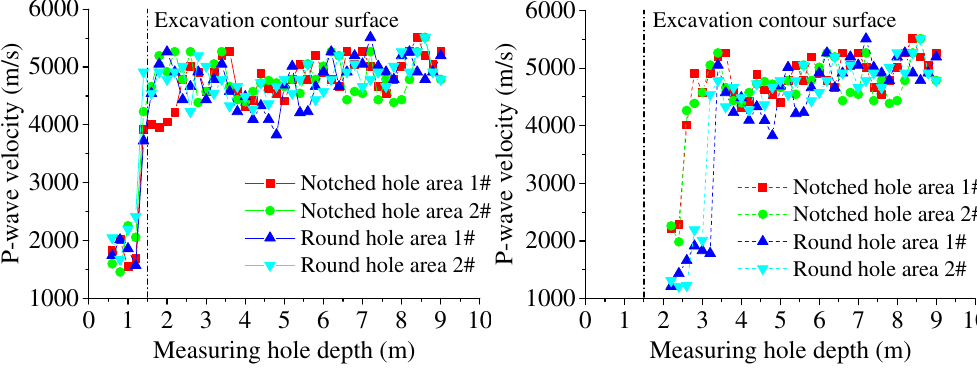
For the Baihetan underground works, the 2# rock emulsion explosive and JWL state equation parameters are shown in Table 2. The state equation of the air media model is expressed by an equation of State (EOS) linear polynomial 38 . The specific parameter values are shown in Table 3.